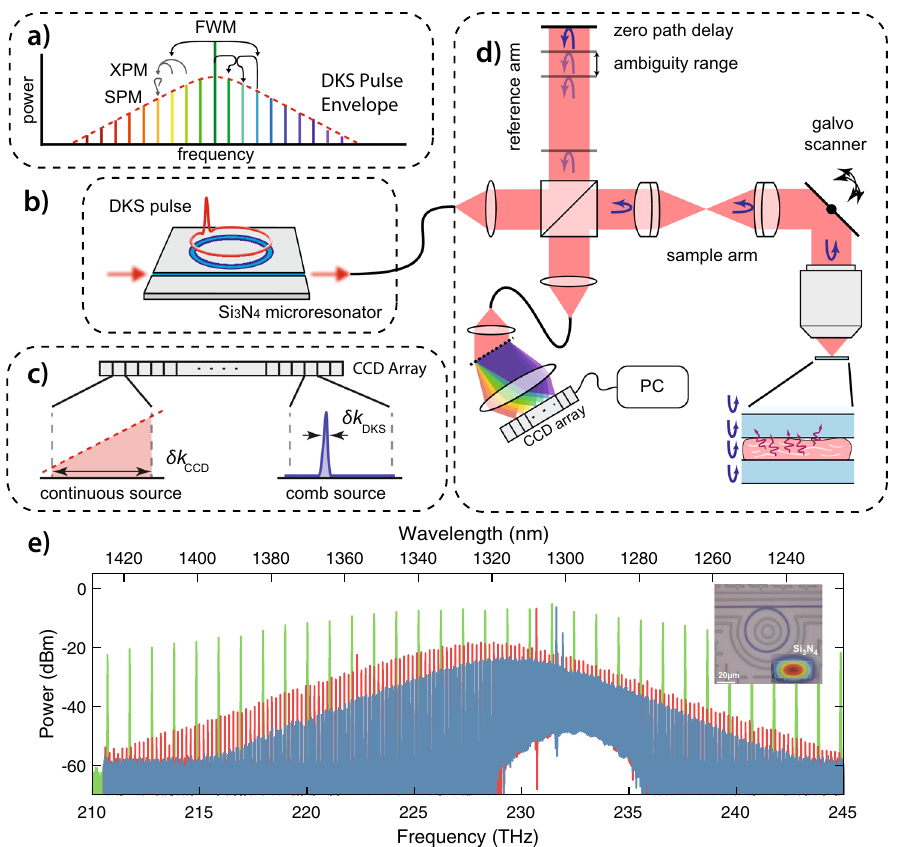
Fig. 1 The principle of dissipative Kerr soliton enabled spectral domain optical coherence tomography (OCT). a A dissipative Kerr soliton (DKS), based on the system shown in b , where a continuous-wave laser drives nonlinear frequency conversion, through four-wave mixing (FWM), cross-phase modulation (XPM) and self-phase modulation (SPM) in a photonic chip-based Si 3 N 4 microresonator. Here, the generated pulse train is comprised of discrete and equally spaced frequency components as determined by the free spectral range of the non-linear cavity. In particular, this process creates a frequency comb via the dual balance between non-linearity and dispersion on one hand, and loss and gain on the other. Eventually, the discrete components of this microresonator frequency comb (or continuous source as in traditional OCT) are dispersively projected onto a charged-coupled device (CCD) array as shown in c , after passing through a standard OCT setup as seen in d . Experimental data for a variety of free spectral ranges (Green 1 THz, Red 200 GHz, and Blue 100 GHz) typical of microresonator DKS are shown in e , along with an inset microscope photograph of a ~1 THz microresonator, and a scanning electron microscopy photograph of a typical bus waveguide in Si 3 N 4